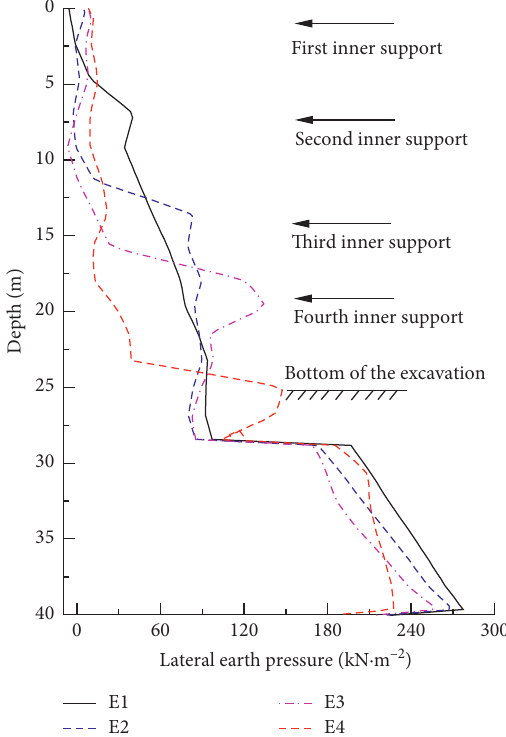
Figure 9: Soil Earth pressure of different excavation stage.